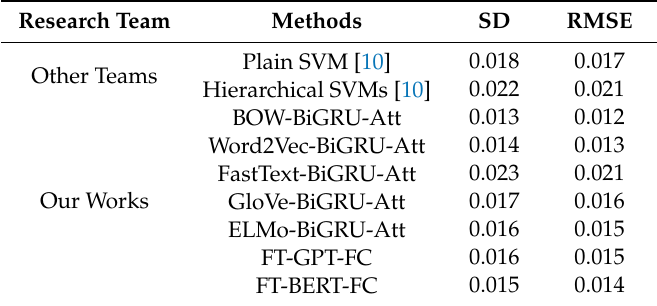
Table 5. Standard deviation and root mean square